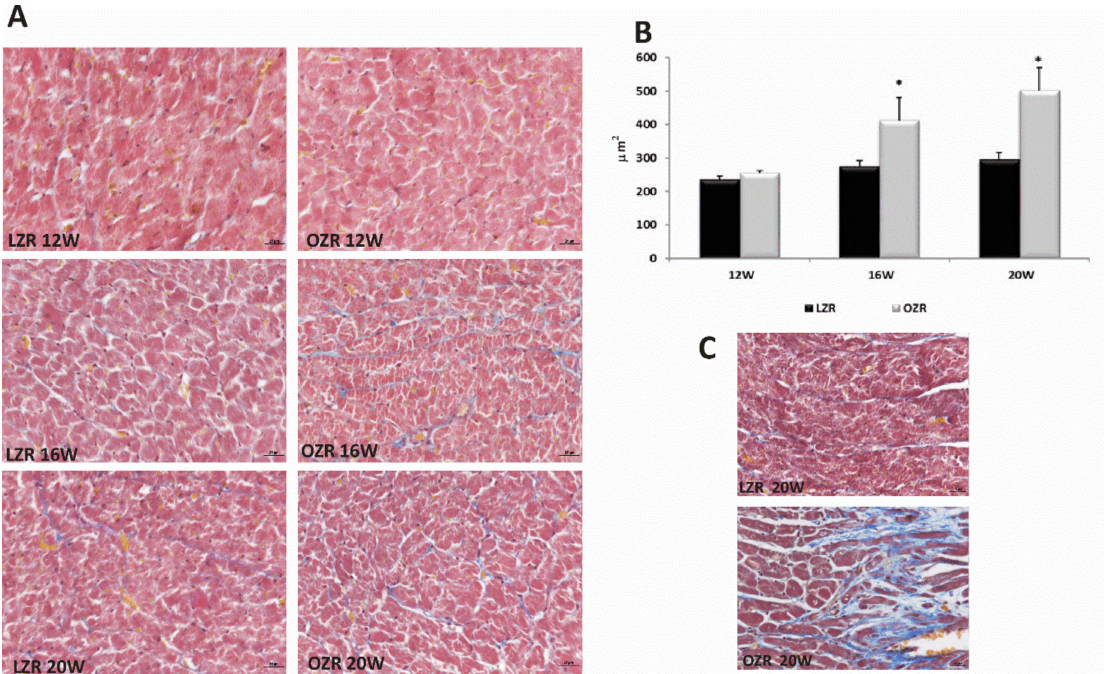
Figure 3. Heart morphology. ( A ) Ventricular sub-endocardium cardiomyocytes in heart tissue of lean Zucker rats (LZR) and obese Zucker rats (OZR) at the age of 12, 16, and 20 weeks, staining with Masson’s Trichrome technique. Magnification 40 × . Calibration bar 25 µ m; ( B ) morphometric analysis to evaluate the size of cardiomyocytes in 12, 16, and 20 weeks old LZR (black bar) and OZR (grey bar). Data are mean ± S.E.M. * p < 0.05 vs. age matched LZR; ( C ) apex of the heart stained with Masson’s trichrome of 20 weeks old lean Zucker rats (LZR) and obese Zucker rats (OZR). Magnification 40 × . Calibration bar 25 µ